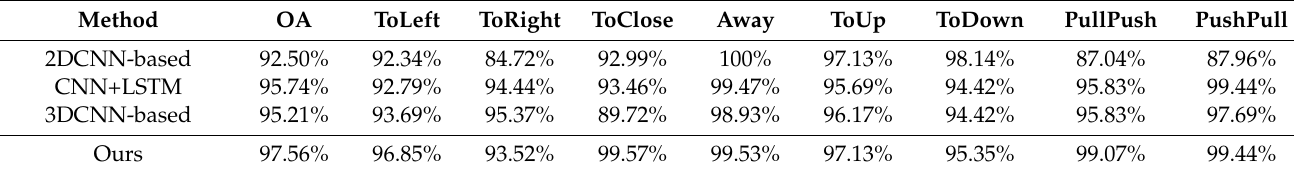
Table 2. Gesture classification results.